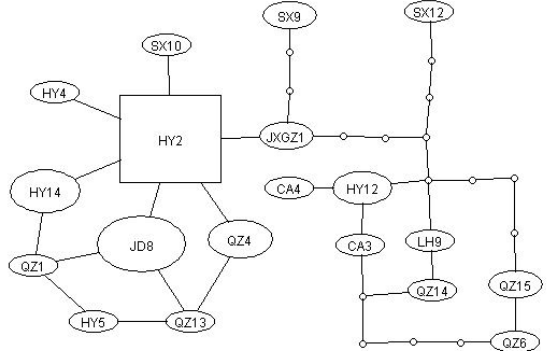
Figure 1. Parsimony network of hyplotypes of Colletotrichum gloeosporioides from Citrus in China. Each mutation is shown as a line between every two haplotypes. The small dots represent unsampled haplotypes.